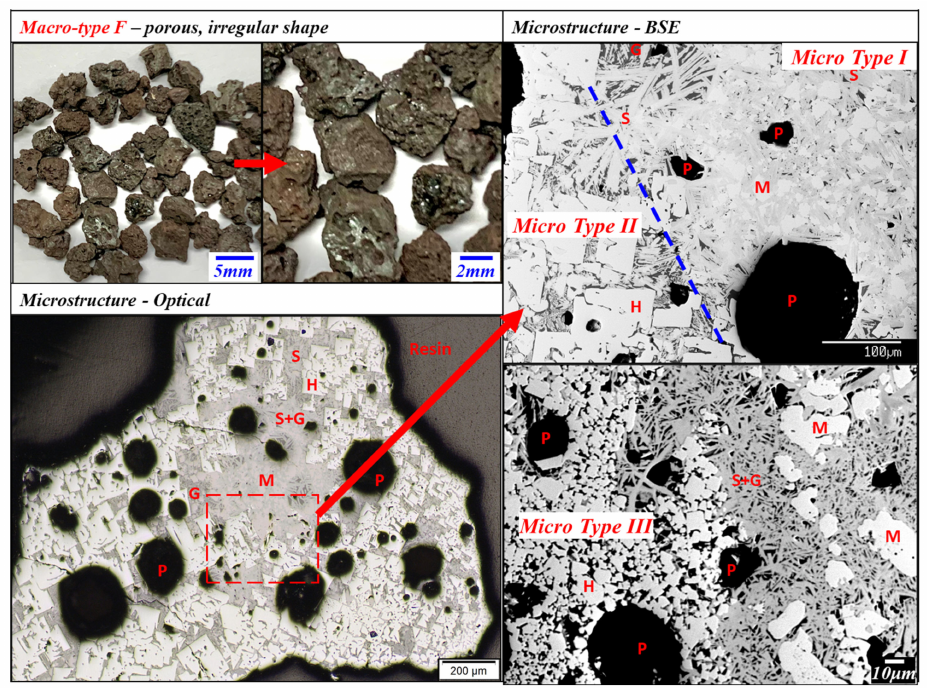
Figure 9. Typical microstructures of return samples Macro-Type F, porous and in irregular shape, taken on optical microscope and back scattered electron microscope, G = Glass; H = Hematite; M = Magnetite; S = SFCA solid solution; and P = Pores.